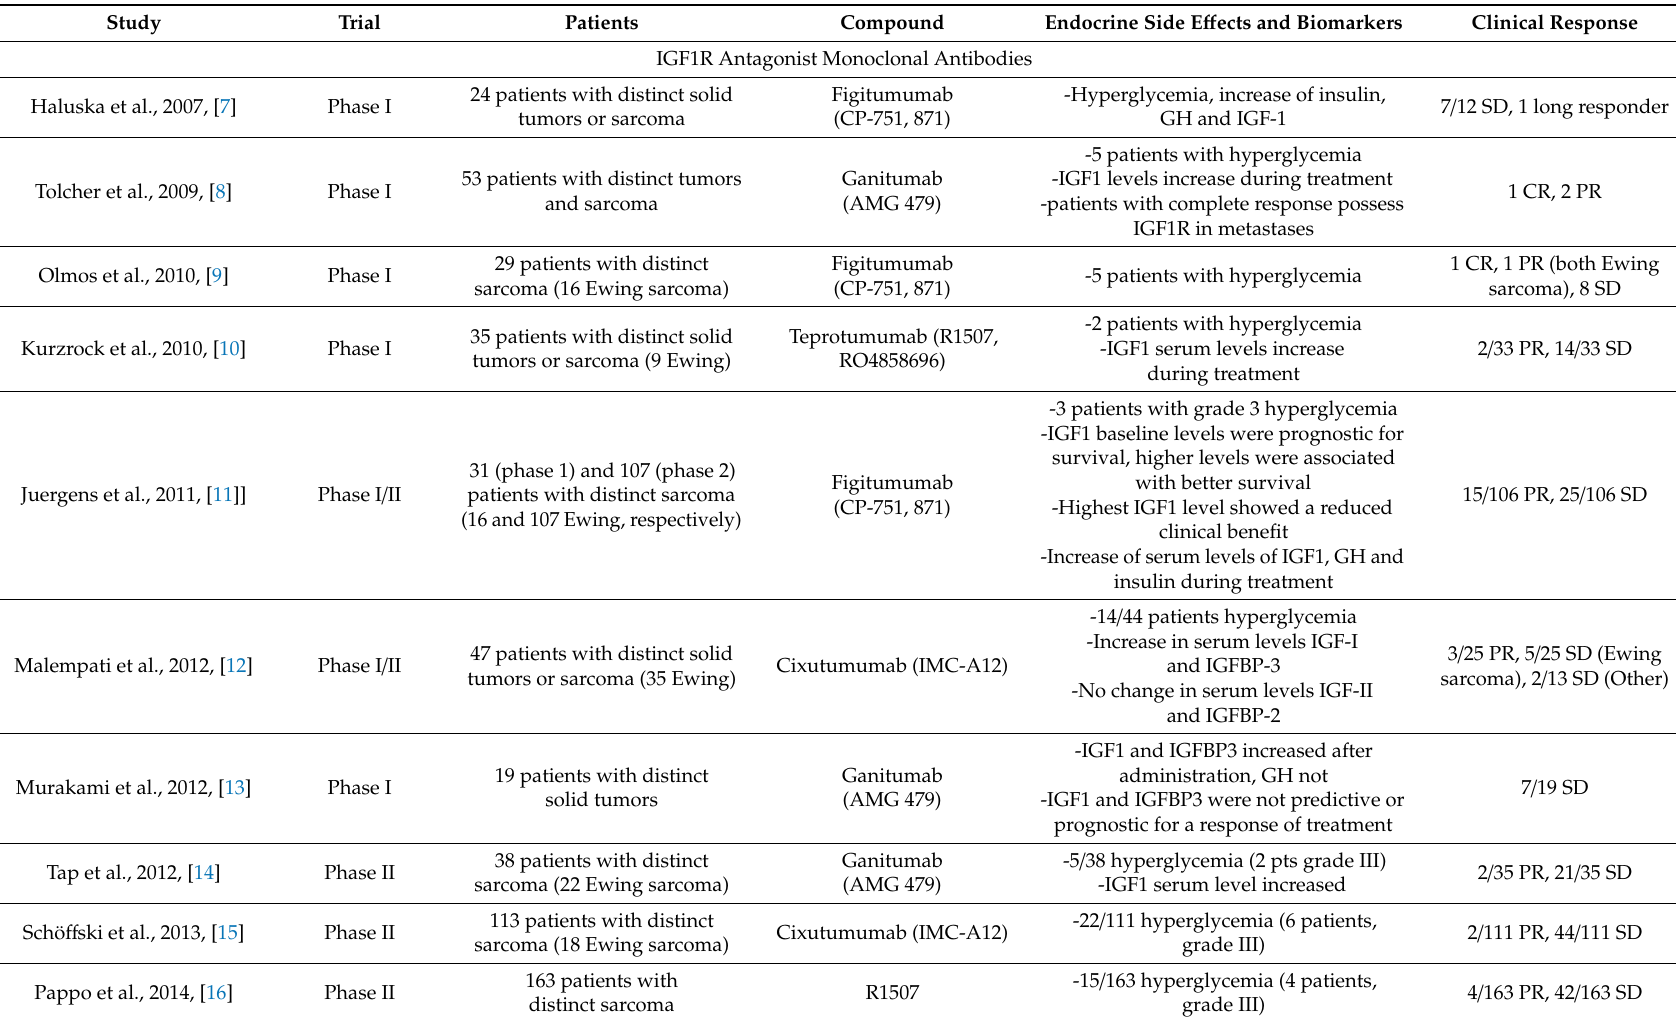
Table 1. IGF1 receptor (IGF1R) pathway inhibitor monotherapy in clinical studies involving patients with Ewing sarcoma and other types of solid